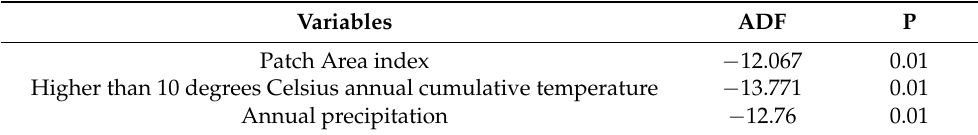
Table 2. ADF test for key variables.